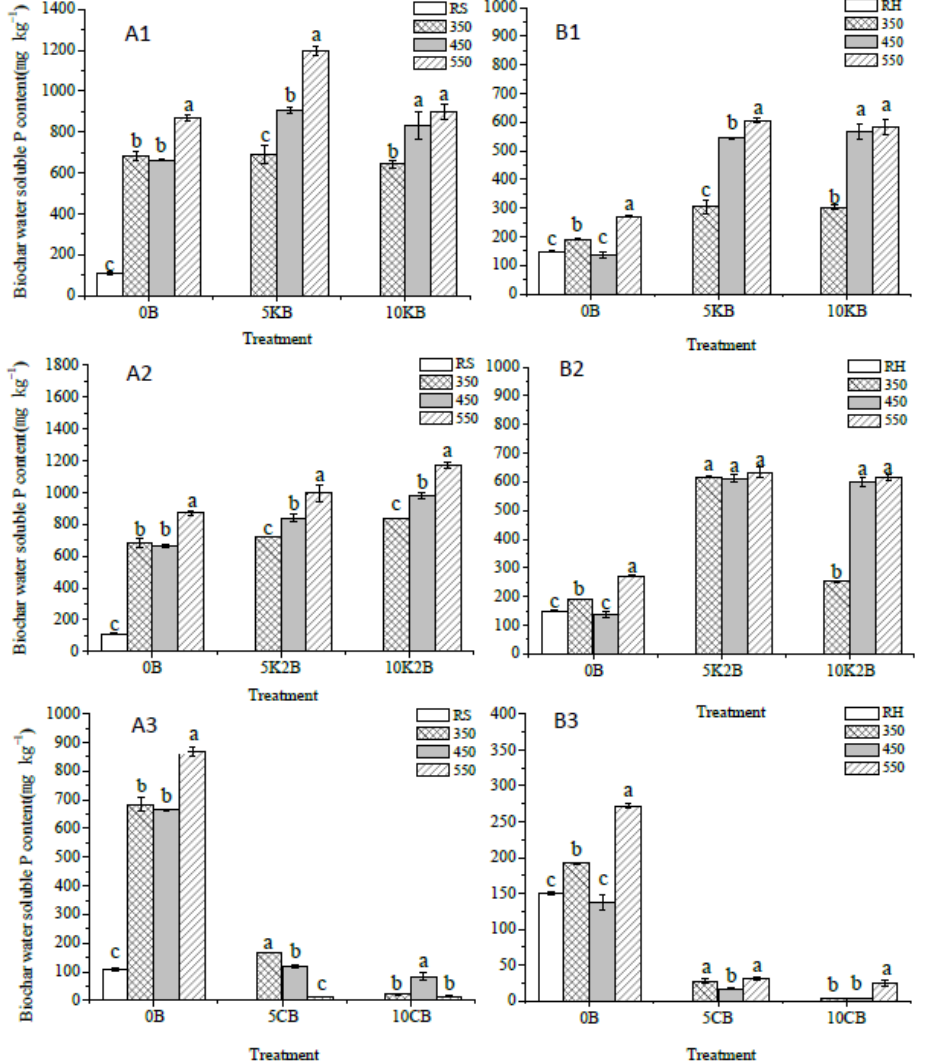
Figure 1. Water soluble P content of alkali-enhanced ( A ) rice straw and ( B ) husk biochar prepared at different pyrolysis temperatures. Note: In the figure, subgraph ( A1 – A3 , B1 – B3 ) indicates KOH, K 2 CO 3 , and CaO of alkali treatments of rice straw (RS) and rice husk (RH), respectively; 0B, 5KB/K2B/CB, and 10KB/K2B/CB indicate the biochars prepared at the proportion of KOH/K 2 CO 3 /CaO to feedstock of 0:100, 5:100, and 10:100. Here, 350, 450, and 550 °C indicate the pyrolysis temperatures. Different letters indicate significant differences within treatment ( p < 0.05) based on Duncan’s multiple range test.